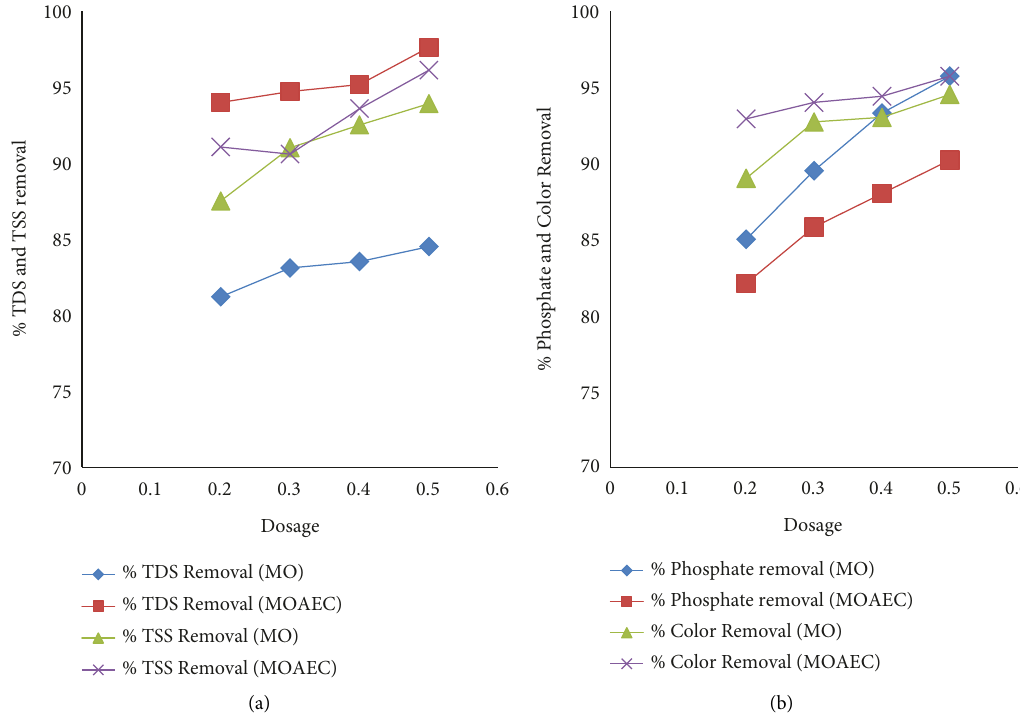
Figure 4: Effects of dosage on TDS and TSS removal efficiency (a) and phosphate and color removal efficiency (b) using Moringa Oleifera (MO) and Moringa Oleifera -assisted EC process